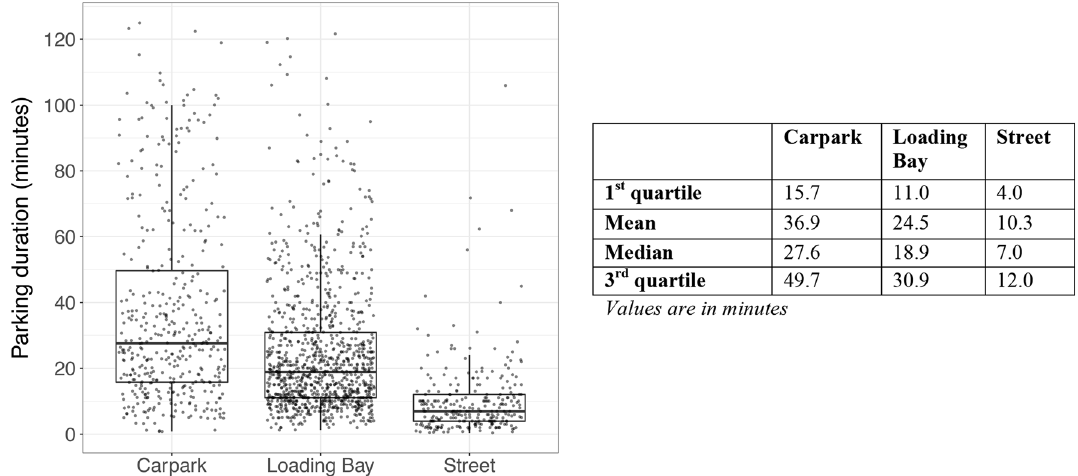
Fig. 4 Boxplot and descriptive statistics of parking duration distributions by parking